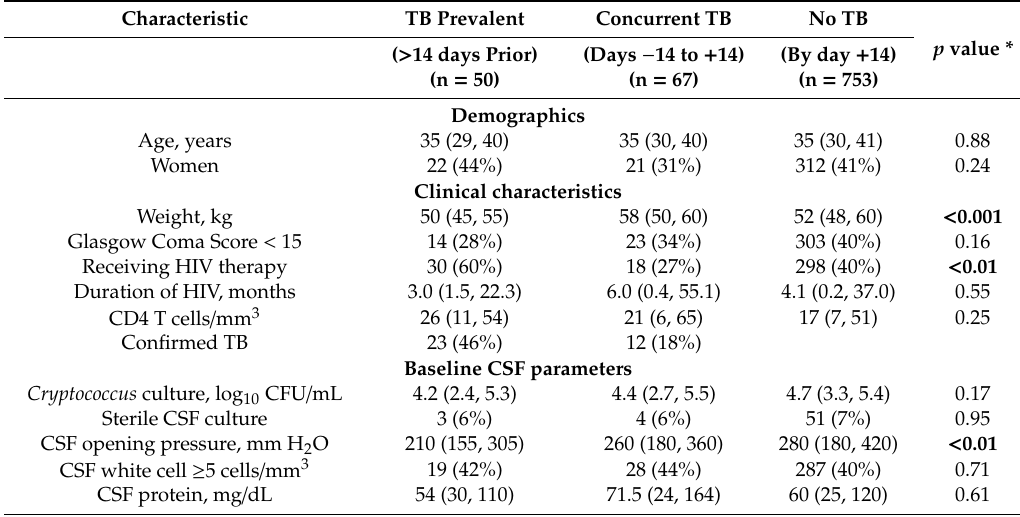
Table 1. Baseline characteristics of the study